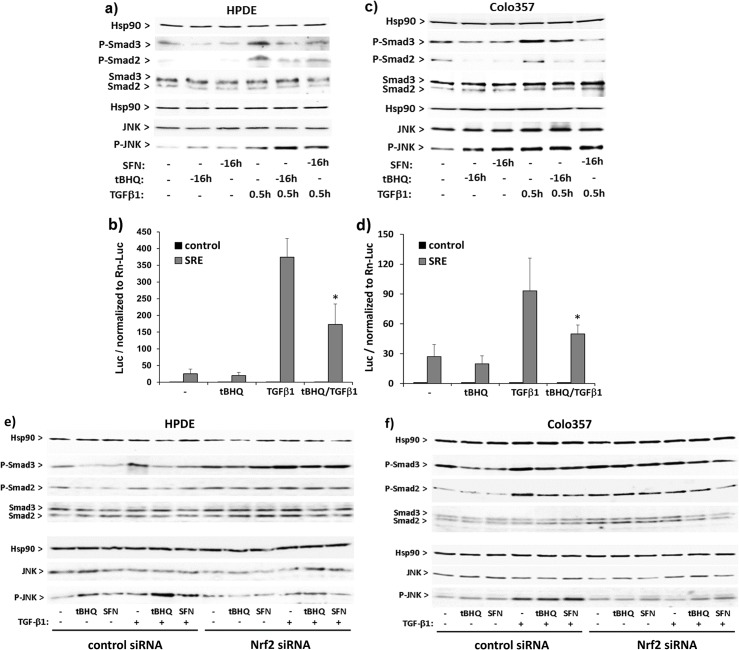
Nrf2 activation affects basal and TGF-β1 dependent Smad and JNK signalling pathways in premalignant and malignant pancreatic duct cells.
A) HPDE or B) Colo357 cells incubated with 50 μM tBHQ, 10 μM SFN or 10 ng/mL TGF-β1 alone or in combination for the indicated periods. Then total cell lysates were analysed by westernblot (A,C) for expression of P-Smad2, P-Smad3, Smad2/3, P-JNK and JNK using Hsp90 as loading control. Representative results from three independent experiments are shown and a densitometric band intensity evaluation is provided in Figs. A and B in S5 File. B) HPDE or D) Colo357 cells were transfected with pGL3 (control) or p6SBE (SRE) together with ptkRL followed by incubation with 50 μM tBHQ and/or 10 ng/mL TGF-β1 or without. After 16h, cell lysates were analysed for firefly and renilla luciferase expression and firefly luciferase units were normalized to those of renilla luciferase. Data represent the mean ± SD of six independent experiments performed in duplicate, p<0.05 (+tBHQ versus-tBHQ). E) HPDE or F) Colo357 cells were treated with Nrf2 or control siRNA for 48h, followed by incubation with 50 μM tBHQ, 10 μM SFN and/or 10 ng/mL TGF-β1, or without. Then, total cell lysates were analysed by westernblot for expression of P-Smad2, P-Smad3, Smad2/3, P-JNK and JNK using Hsp90 as loading control. Representative results from three independent experiments are shown, and a densitometric band intensity evaluation is provided in Figs. C and D in S5 File.